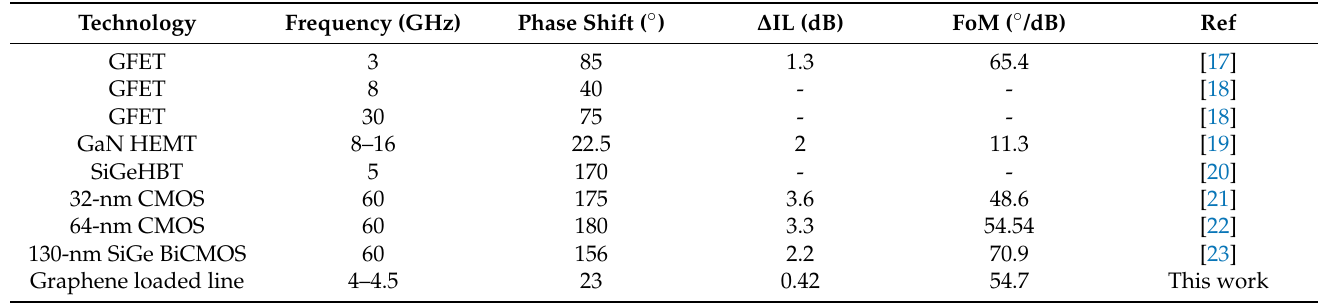
Table 2. Comparison of the phase shifter performance with state of the art phase